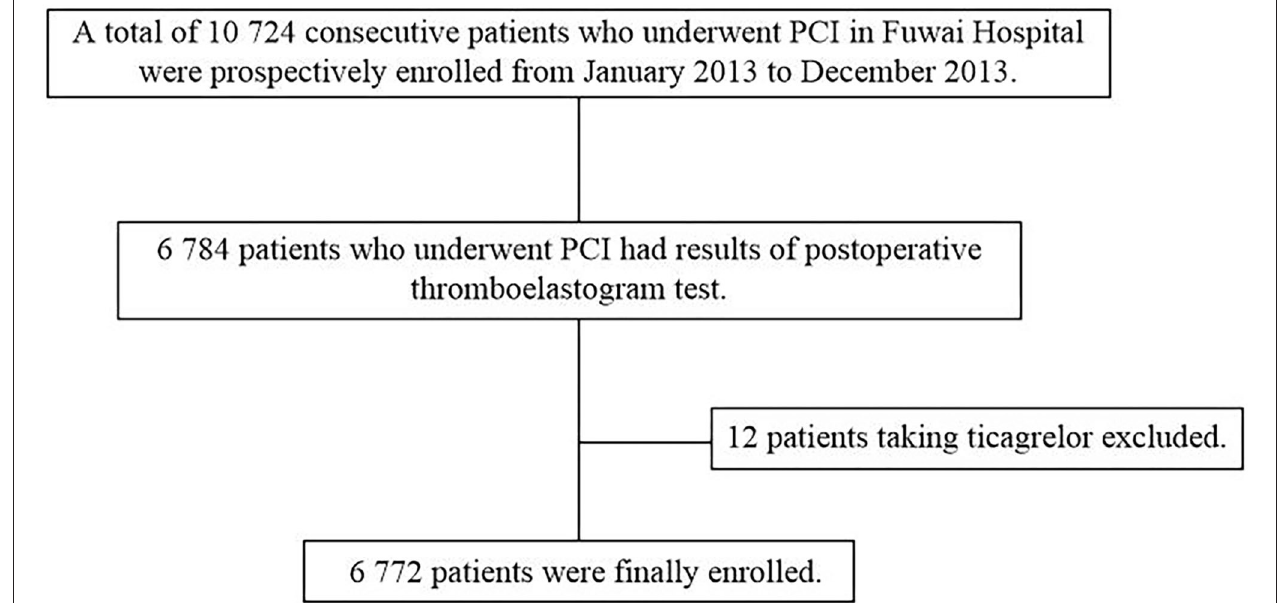
FIGURE 1 | Flowchart of the study. PCI, percutaneous coronary